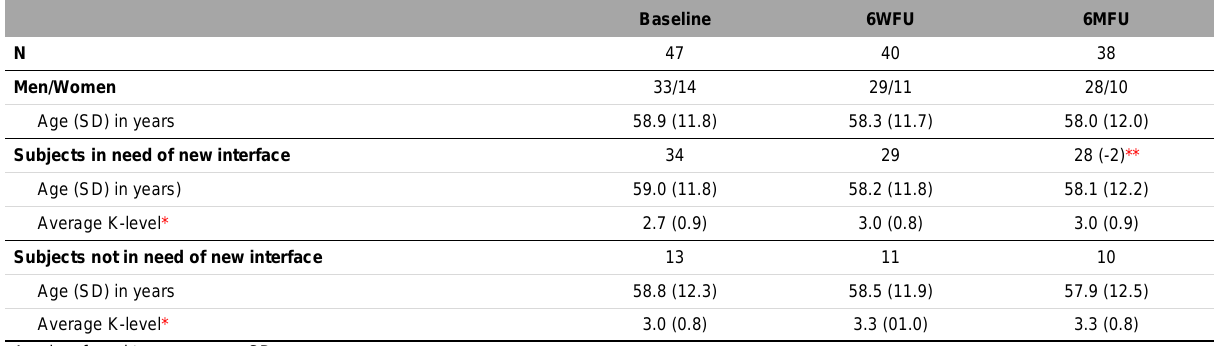
Table 2 : Characteristics of the study population stratified into follow-up periods according to those prosthetic users in need or not in need of a new interface.